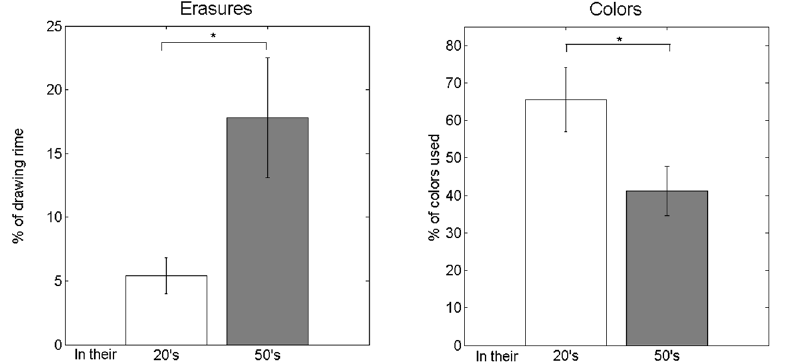
Fig 14. Depiction of age-significant differences. Differences in the means of parameters have emerged for participants in their 20s and in 50s. Mean differences are shown in the percentage of use time of the eraser ( n = 18), and in the number of colors used, computed here as the percentage of colors used ( n = 18). Data are reported as the mean ± SEM. * p <